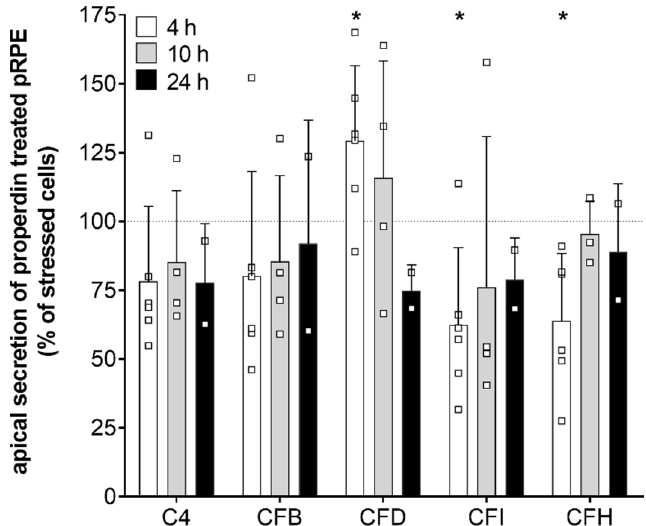
Figure 4. Complement protein secretion was modulated in stressed hpRPE cells by properdin. Complement protein secretion into the apical supernatant 4 h (white), 10 h (grey) and 24 h (black) after properdin treatment of H 2 O 2 stressed hpRPE is shown as percentage of the secretion level of stressed, non-properdin treated cells (dotted line). We observed a time-dependent change in CFD levels (significantly increased after 4 h) in apical supernatants of stressed properdin-treated hpRPE cells. Decreased concentrations of complement regulators CFI and CFH were detected after 4 h of properdin treatment. Shown are data of donors 2, 4, and 8 for 4 h; donors 3, 5, and 6 for 10 h; donor 1 for 24 h. Mean with standard deviation is shown. * p < 0.05, ** p < 0.01 t -test with Welch‘s correction of stressed hpRPE versus stressed, properdin-treated hpRPE.